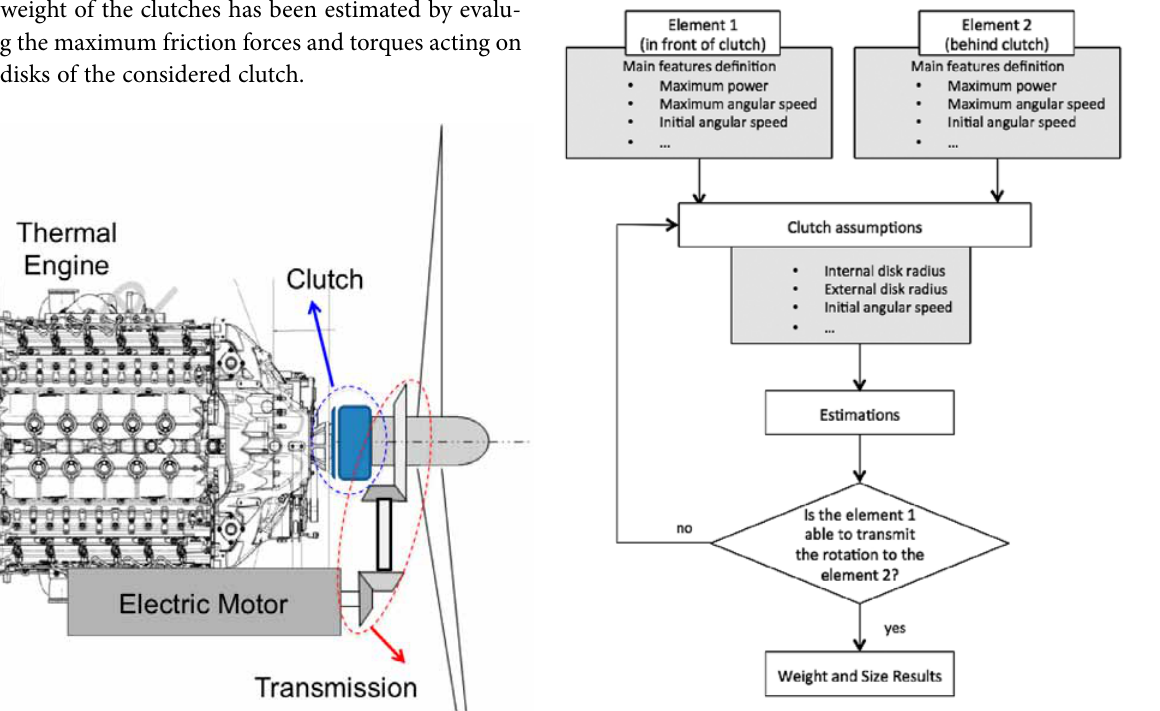
Fig. 12. “Ideal Weight” sizing methodology applied to a clutch weight